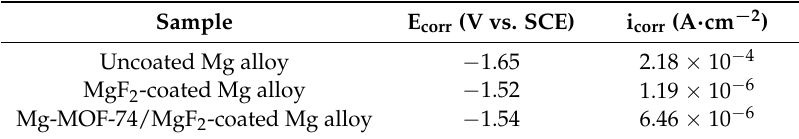
Table 1. Results of Tafel polarization tests in SBF